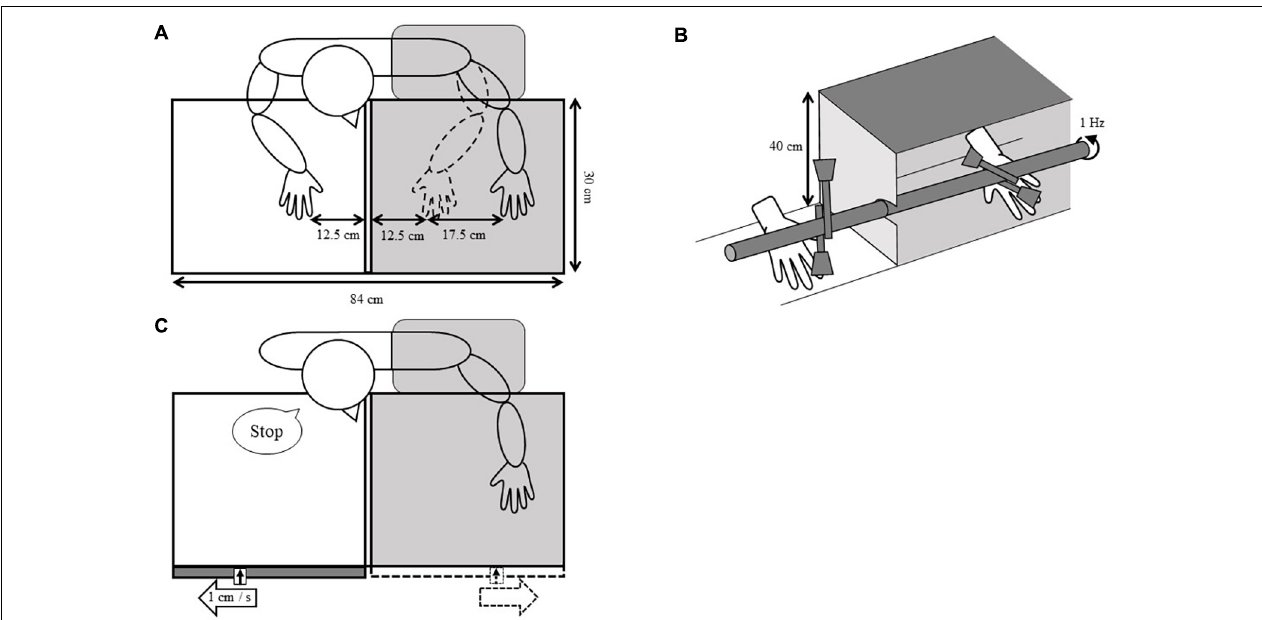
FIGURE 1 | Experimental setup. (A) Hand position for the tactile stimulation. The participants sat on the chair, and their right hand was placed in the front of the reflective surface, whereas their left hand was positioned behind the mirror. The broken lines illustrate the mirror image seen by the participants. (B) Tactile stimulation device. Tactile stimulation was delivered by rotating a pole with the brushes. The angle of the brushes behind the mirror could be adjusted according to the stimulation conditions. This figure shows the asynchronous condition. (C) Finger point judgment task. The ruler with a marker was attached to the front of the mirror box. While looking at the mirror image of the horizontally moving marker, the participants verbally responded to the position where their left index finger and the marker vertically aligned. The broken lines illustrate the mirror image seen by the